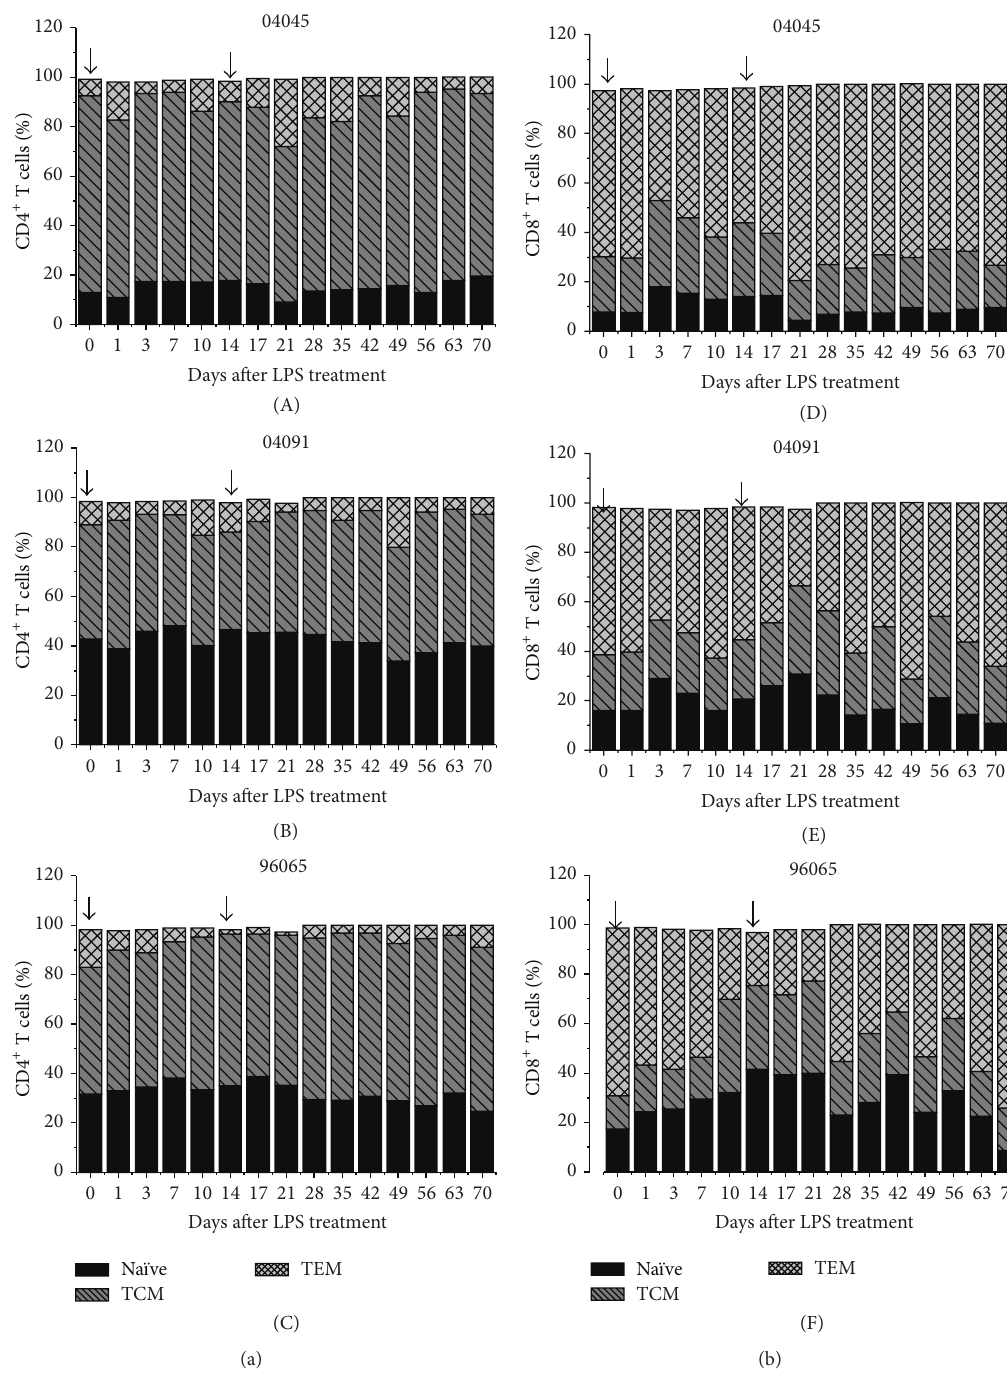
Figure 4: Frequency of na¨ıve and memory CD4 + or CD8 + T cells in LPS-treated Ch-RMs. CD3 + CD4 + (a) and CD3 + CD8 + (b) T cells were assessed for CD28 and CD95 expression to identify na¨ıve (CD28 + CD95 − ), central memory (TCM; CD28 + CD95 + ), and effector memory (TEM; CD28 − CD95 + ) cell subsets. The percentages of na¨ıve CD8 + T cells increased after LPS administration, and effector memory CD8 + T cells decreased compared to baseline values. Baseline values were taken prior to LPS administration.